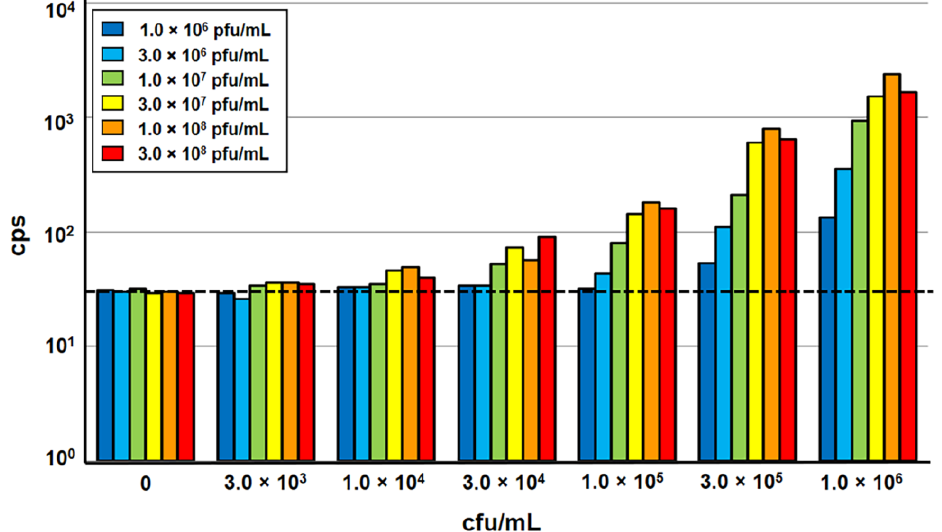
Figure 1. Evaluation of optimum bacteria:phage ratios in a 96-well microplate-based A511:: luxAB assay. Increasing concentrations of Listeria monocytogenes ScottA (3.0 × 10 3 to 1.0 × 10 6 cfu/mL) were incubated with luciferase reporter phage A511:: luxAB (1.0 × 10 6 to 3.0 × 10 8 pfu/mL). Bacteria were